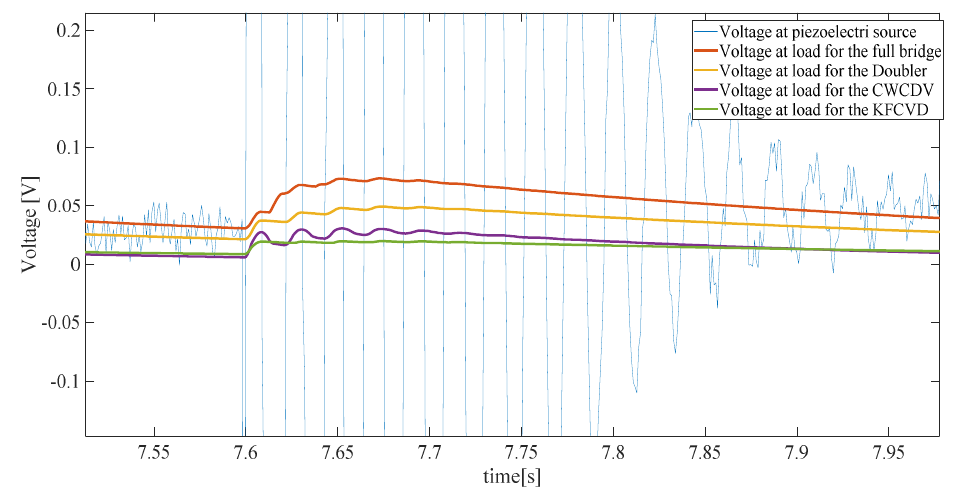
Figure 20. Voltage obtained for internal resistance of 100 kΩ for the eighth drop. Full bridge has the best performance.